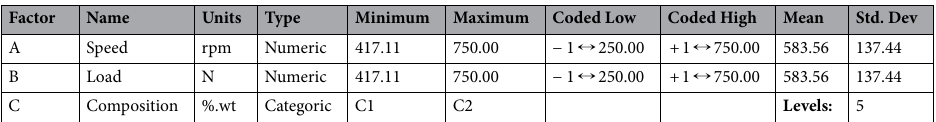
Table 3. Build information for the design factors.